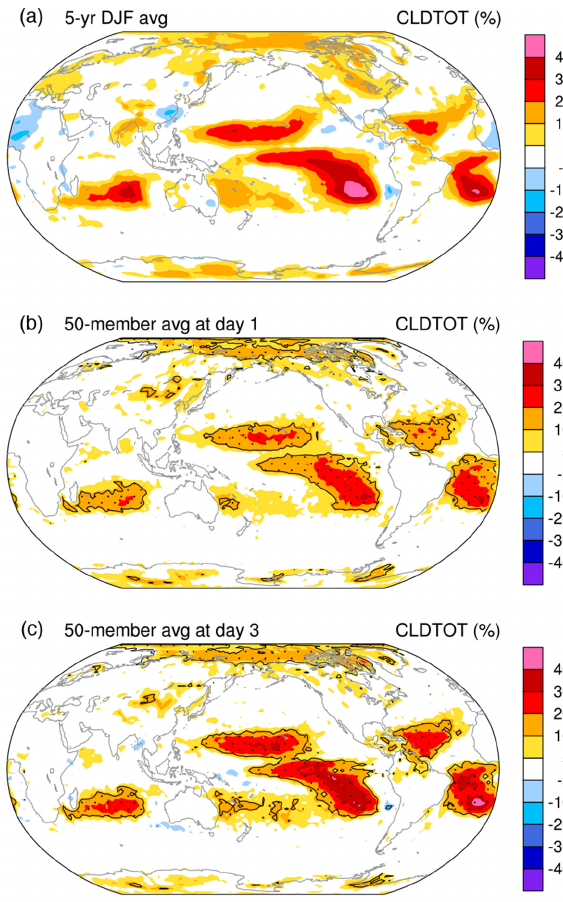
Figure 2. Differences in total cloud cover (unit: %) between sim- ulations using 4 and 30min time steps. (a) 5-year DJF average from a climate simulation performed in the traditional way; (b) 50- member ensemble average of the first simulation day; (c) as in (b) but for the third simulation day. Stippling in panels (b) and (c) in- dicates where the differences are statistically significant at the 95% confidence level. Further details are explained in Sect. 3.2.